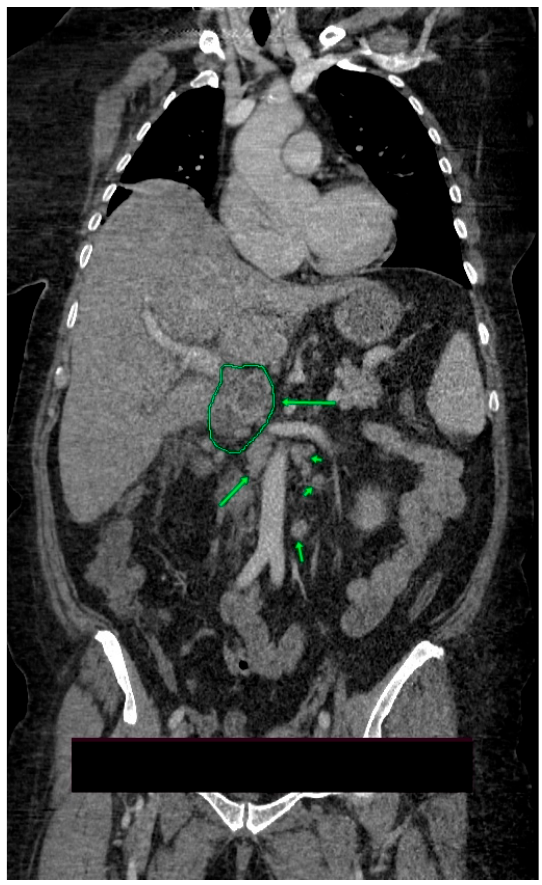
Figure 1. Contrast-enhanced abdominal pelvic computed tomography, venous phase, coronal imaging plane: globally enlarged, irregularly shaped, inhomogeneous cephalic contours of the pancreas, multiple periaortic and interaortocaval lymph nodes.